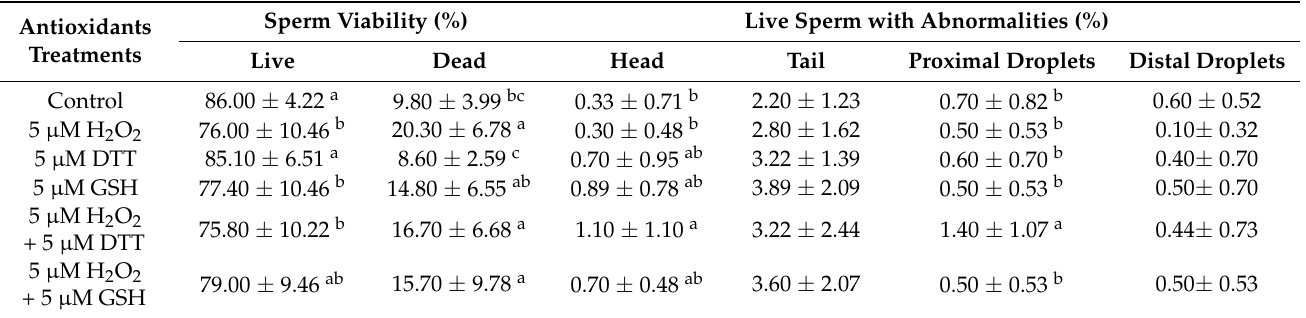
Table 5. Characterization of sperm viability and morphology traits of treated Large White boars’ semen following in vitro liquid preservation under induced oxidative stress (mean ±